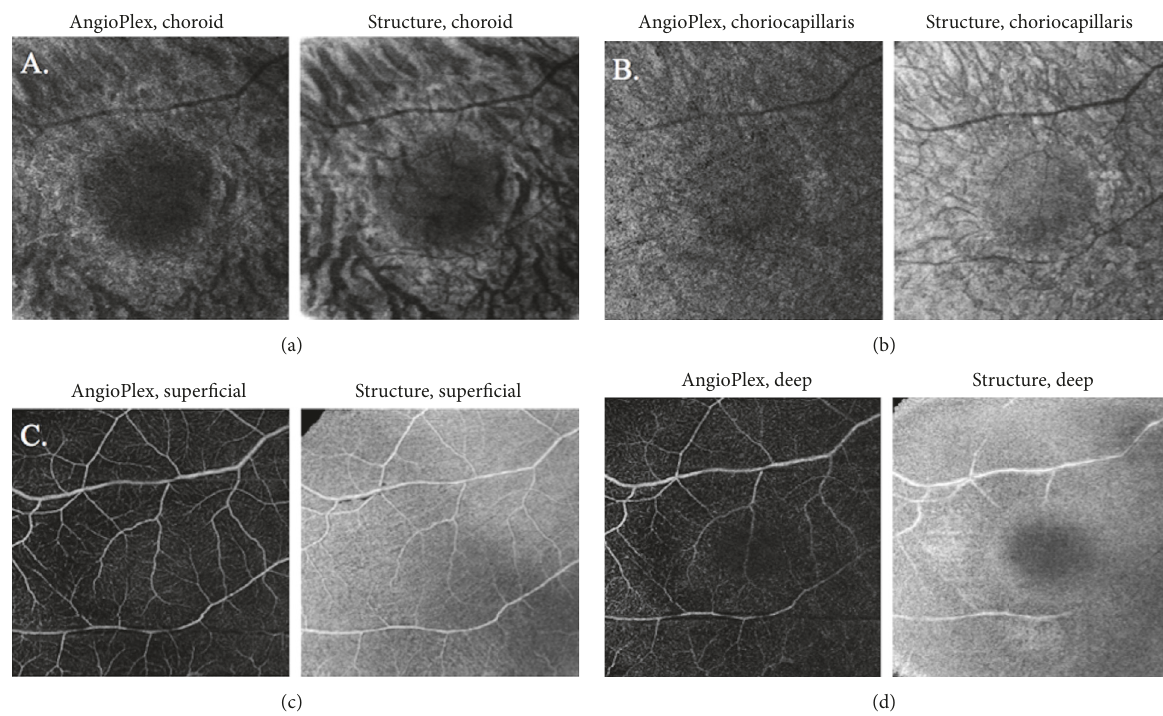
Figure 4: AngioPlex OCT-A 6mm × 6 mm. (a) Choroidal plexus layer showing a decreased vascular flow signal. (b) Choriocapillary plexus layer showing a decreased vascular flow signal. (c) Superficial retinal plexus layer showing a normal vascular flow signal. (d) Deep retinal plexus layer showing a subtle central decreased vascular flow